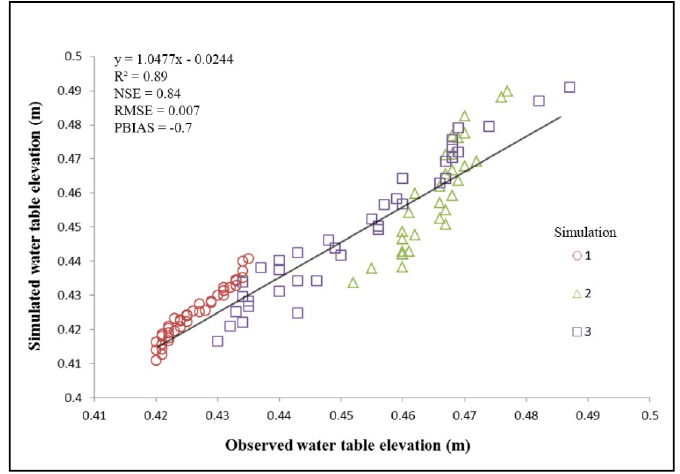
Figure 7. Simulated vs. observed water table elevation values.